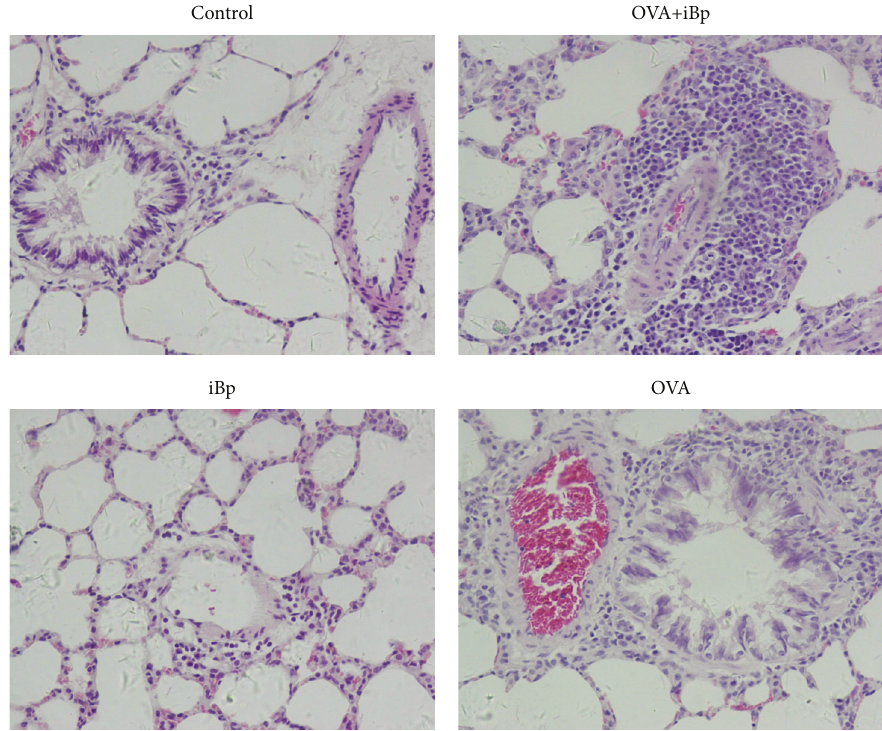
Figure 6: Representative histological alterations of the small airways and small blood vessels in control, OVA+iBp, iBp, and OVA rats.